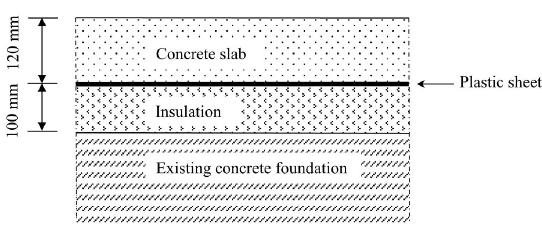
Figure 2. Cross-section of slab and subgrade.